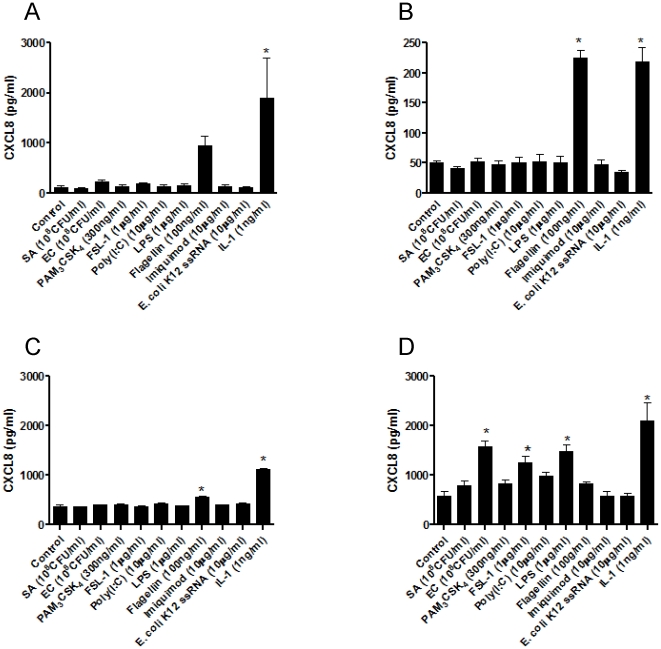
Response of hESC and primary cells to bacteria and PAMPs.Release of CXCL8 from undifferentiated (A), 1 month- (B) or 4 month- (C) differentiated H7 hESC or from primary cultures of human aortic endothelial cells (D). Cells were treated with Gram negative E. coli (C, 108 CFU/ml), Gram positive S. aureus (SA, 108 CFU/ml), PAMPs for TLR2/1 (PAM3CSK4; 300 ng/ml), TLR2/6 (FSL-1; 1 mg/ml), TLR3 (Poly:IC; 10 mg/ml), TLR4 (LPS; 1 mg/ml), TLR5 (flagellin; 100 ng/ml), TLR7 (imiquimod; 10 mg/ml) or TLR8 (E. coli 12 ssRNA; 10 mg/ml) or IL-1β (IL-1; 1 ng/ml) for 24 hours before CXCL8 was measured using ELISA. The data are the mean ± S.E. mean for n = 8−11 (A); n = 3−9 (B); n = 3 (C) and n = 4−6 (D). Statistical significance was calculated by one-way analysis of variance followed by Dunnett's Multiple Comparison Test (to control). A p value of less than 0.05 was considered statistically significant and denoted by *.